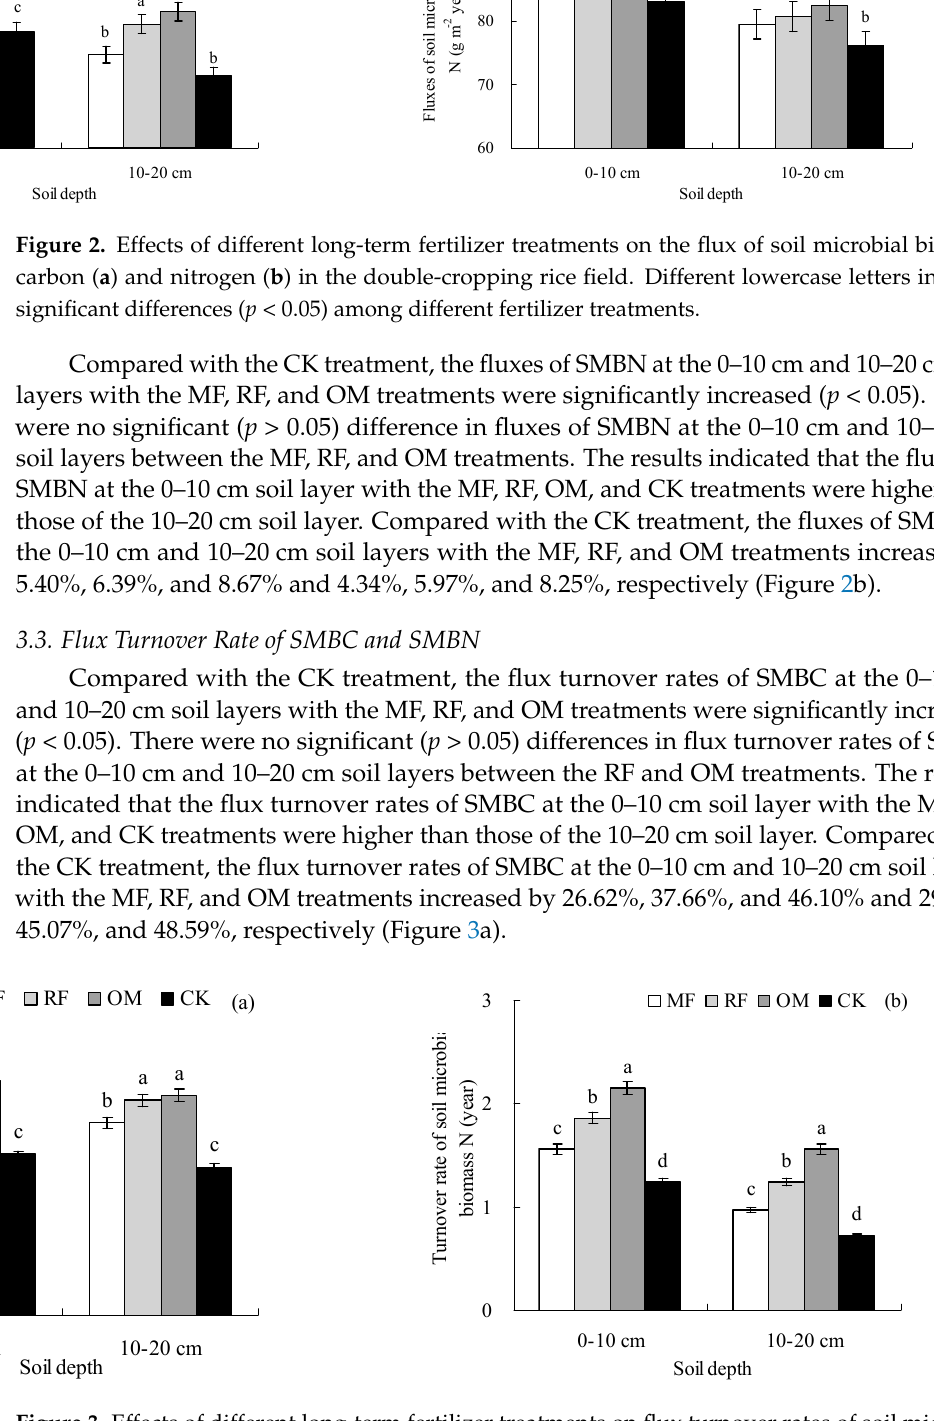
MF RF OM CK Figure 4. Effects of different long-term fertilizer treatments on flux turnover time of soil microbial biomass carbon ( a ) and nitrogen ( b ) in the double-cropping rice field. Different lowercase letters indicate significant differences ( p < 0.05) among different fertilizer treatments. Compared with the CK treatment, the flux turnover times of SMBN at the 0–10 cm and 10–20 cm soil layers with the MF, RF, and OM treatments were significantly de-